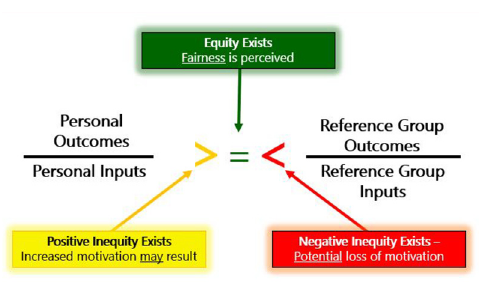
Figure A1. Adams ’ equity